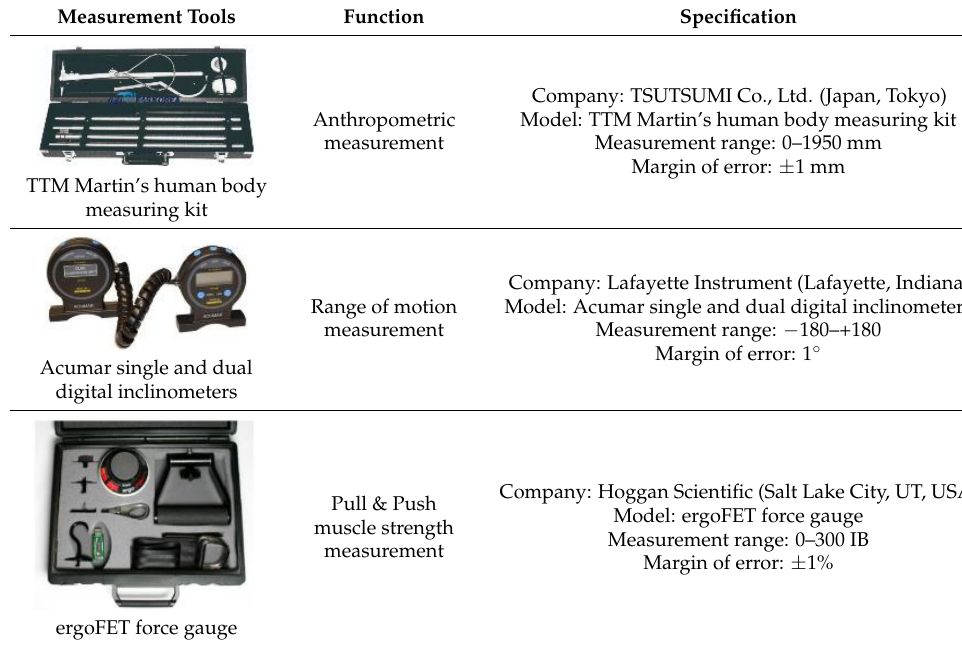
Table 4. Measurement instruments of anthropometry, range of motion, and upper limb muscle strength.